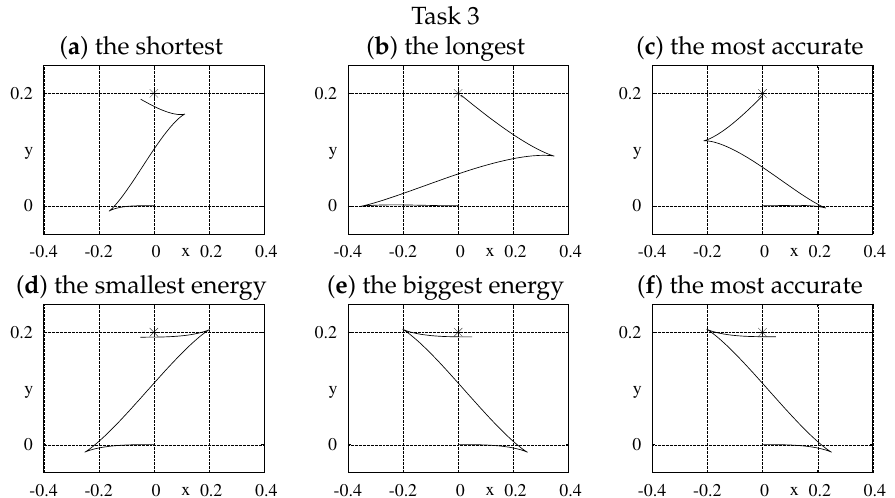
Figure 2. xy -plane projections of some paths generated with basic ( a – c ) and null-space optimization ( d – f ) versions of the Newton algorithm run for the unicycle robot.